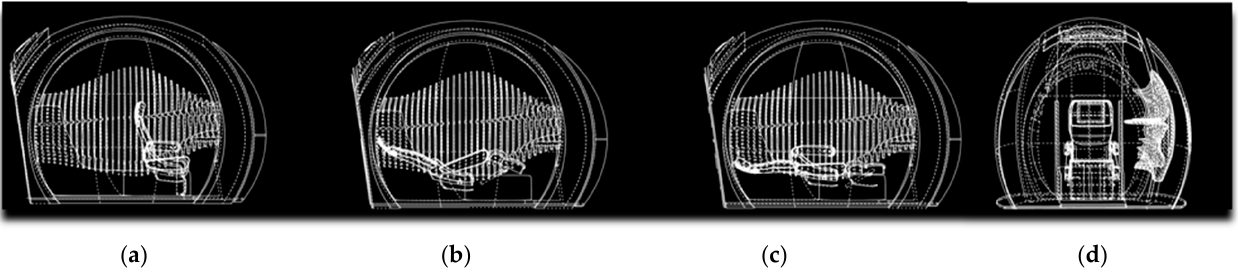
Figure 10. Technical drawings illustrating the parametric wall unit and different positions for the adjustable smart seat: ( a ), working/meeting position, ( b ) relaxation/meditation position ( c ), napping position, and ( d ) front view (designed by the authors).